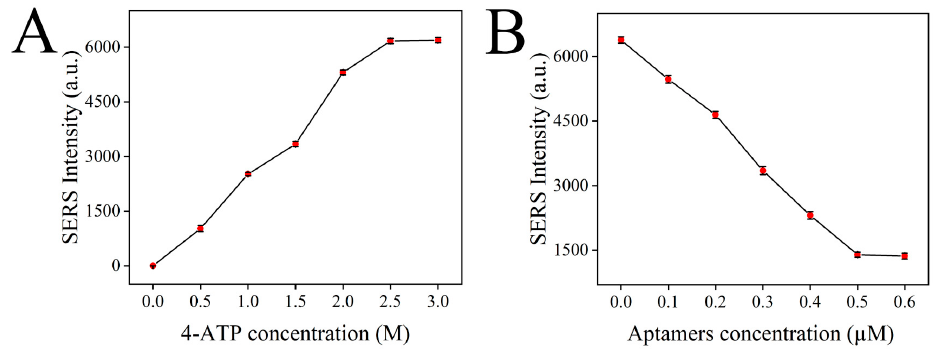
Figure 8. Optimization of the detection conditions: 4-ATP concentration ( A ); aptamer concentration ( B